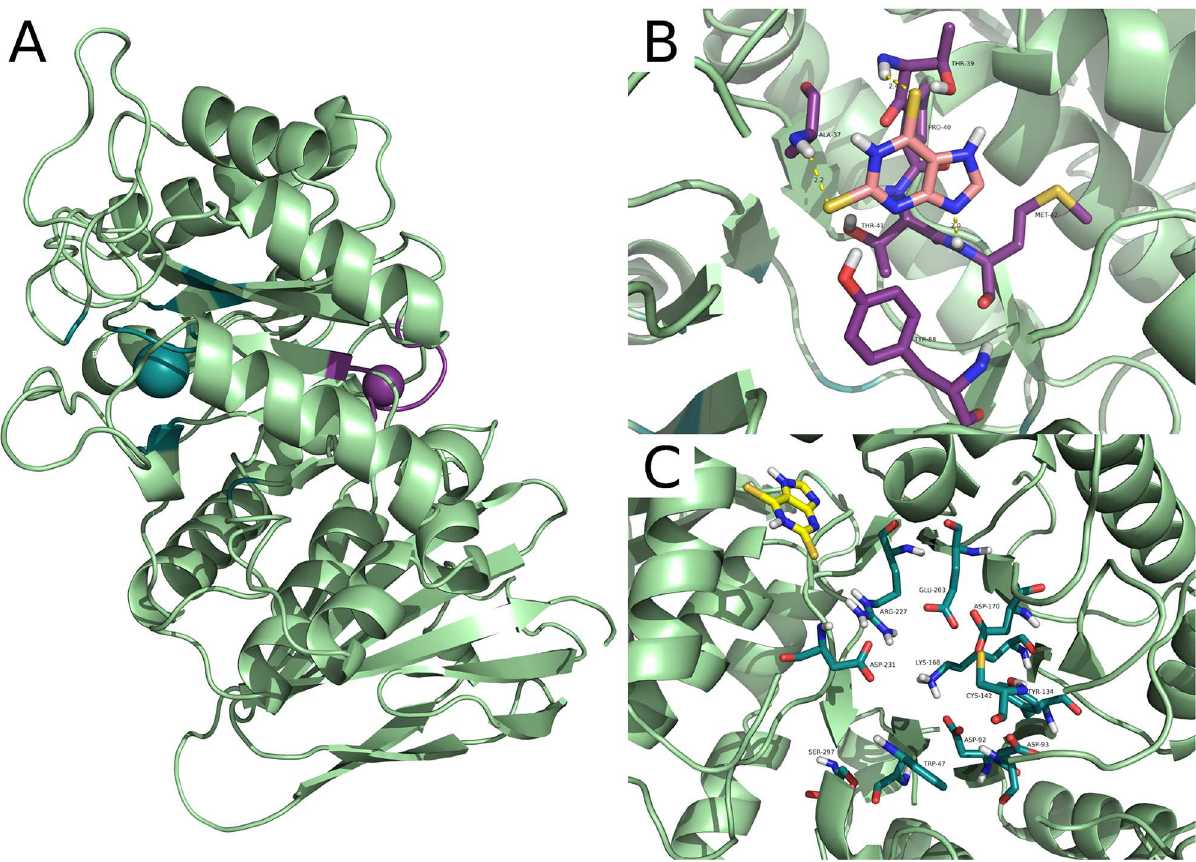
Fig 1. The active site and the allosteric binding site in human lysosomal alpha-galactosidase. The structure of lysosomal alpha- galactosidase is shown as a cartoon. In Panel A the active site (GLA site) is pinpointedby a blue sphere while the allostericbindingsite is pinpointedby a violet sphere. Residuesinvolvedin the 2,6-dithiopurine allostericand alpha-galactose bindingsite respectivelyare shown as sticks in Panel B or C respectively along with docked DTP. Predicted hydrogen bonds between DTP and AGAL within the allosteric bindingsite are shown as yellow dashedlines in Panel B. Best ranked pose of DTP in the alpha-galactose bindingsite area is shown in Panel C.